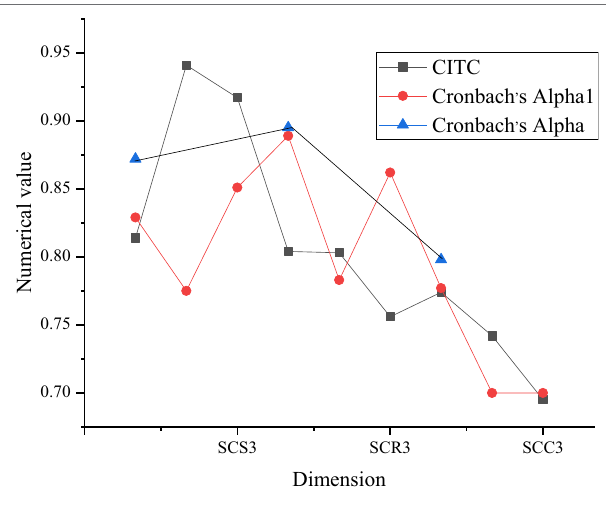
FIGURE 4 | Reliability analysis of social capital (SCS3 represents three evaluation factors of social capital structure dimension, SCR3 represents three evaluation factors of relationship dimension, and SCC3 represents three evaluation factors of cognitive